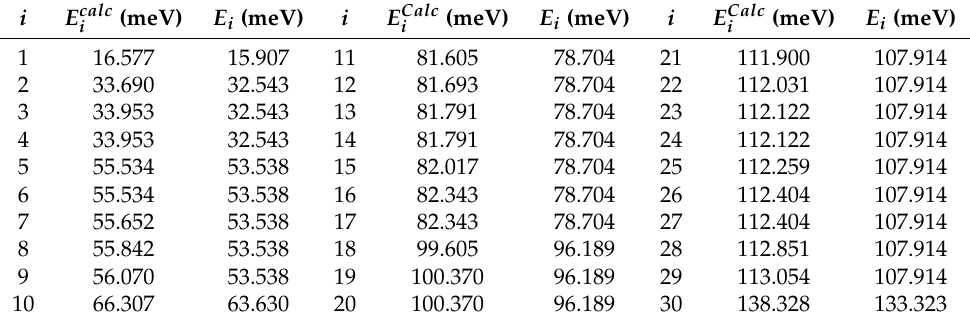
Table 1. Comparison of calculated, E Calc